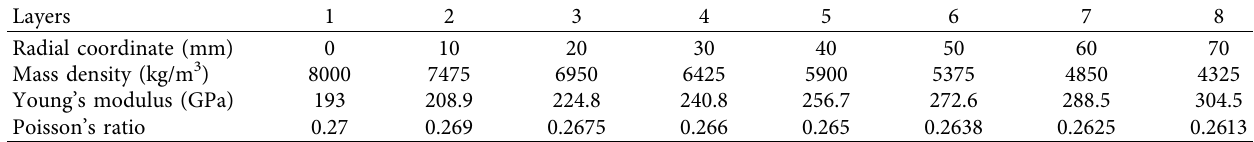
Table 6: Material properties of FGM (316 steel+Al